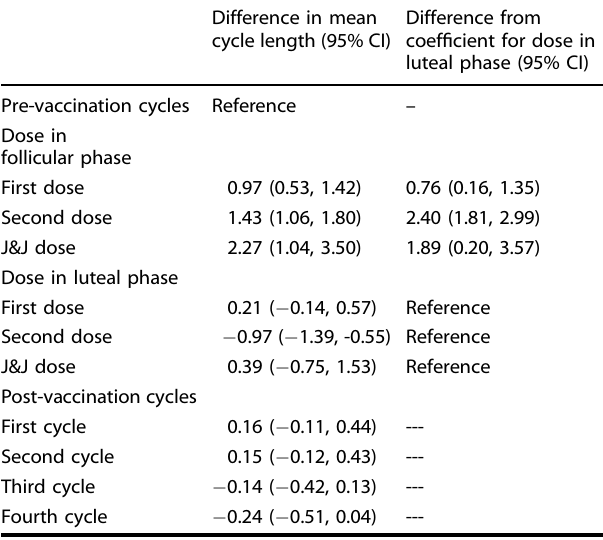
Table 3. Adjusted within-participant change in mean menstrual cycle length and 95% con fi dence intervals (95% CIs) comparing cycles in which a vaccine was administered and post-vaccination cycles with pre-vaccination cycles by menstrual cycle phase of vaccine dose. Difference in mean Difference from cycle length (95% CI) coef fi cient for dose